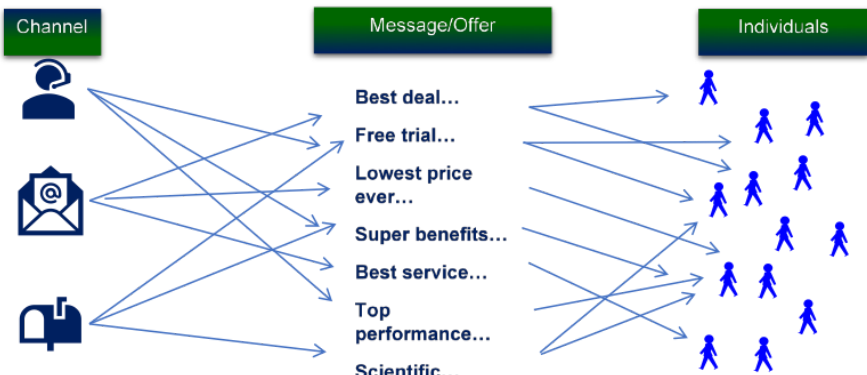
Figure 5. Optimization for Customer Relationship Management